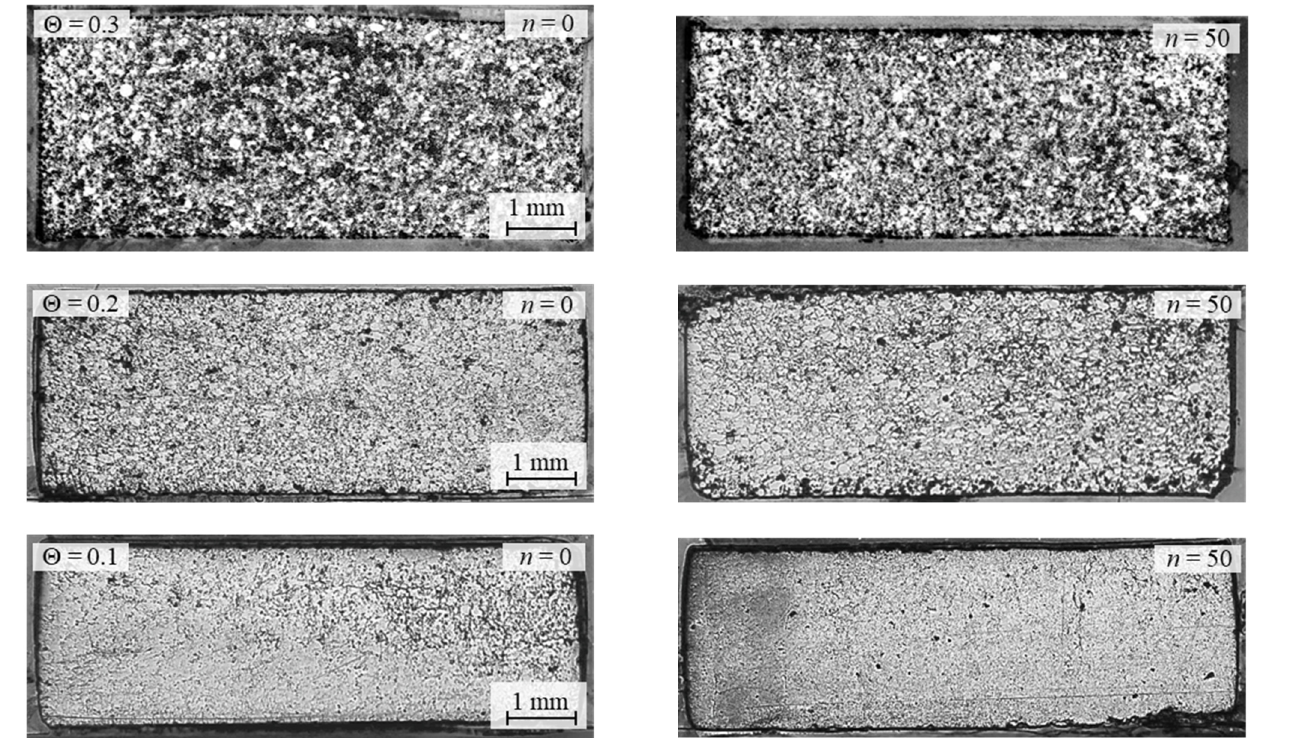
Figure 4. Optical macrographs showing the porosity distribution of the CEDC specimens after 0 and 50 discharges.